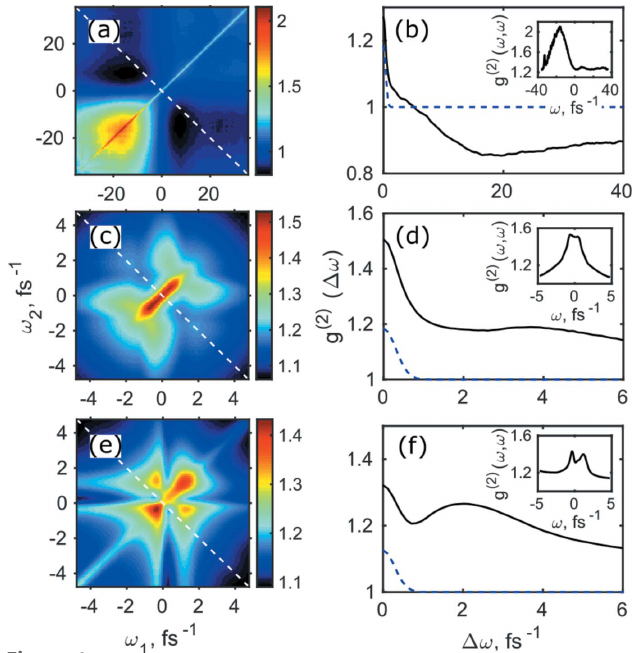
resolution function of the monochromator, we obtain for